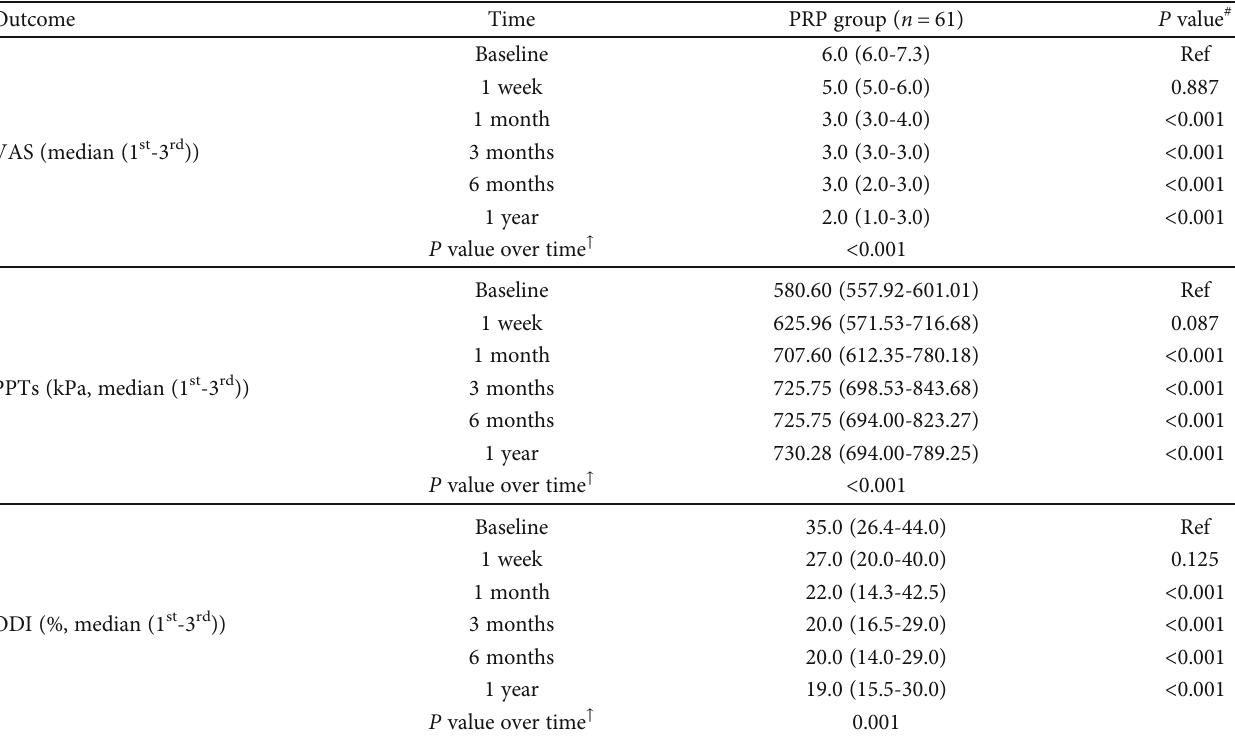
Table 2: Longitudinal outcomes of pain degree and spinal function for the PRP group over